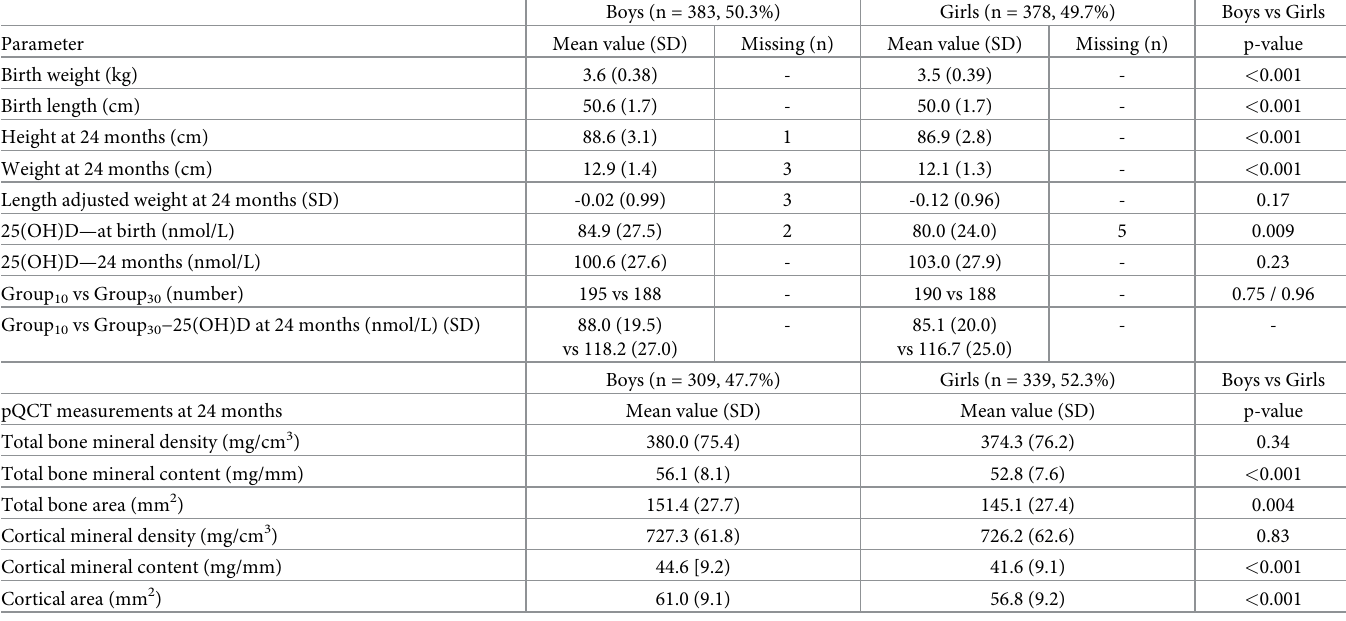
Table 1. Anthropometric, biochemical and skeletal parameters in the